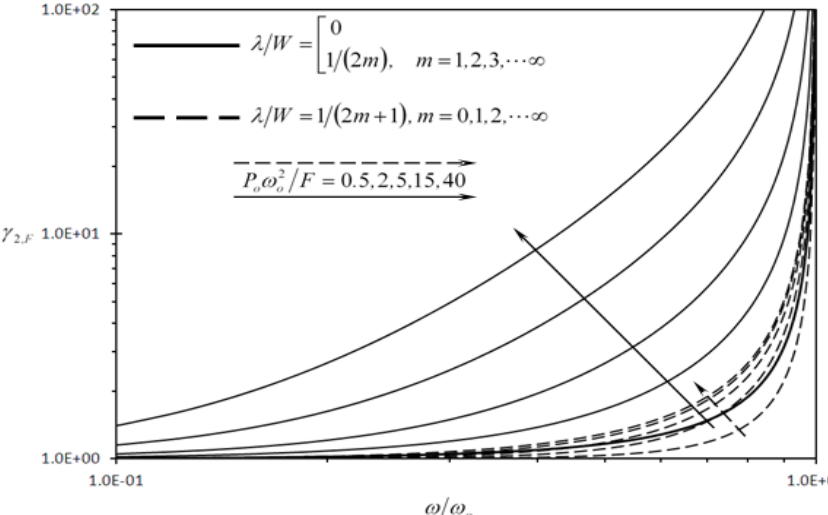
Figure 11. Effects of the dimensionless frequency of dynamic disturbance ( ω / ω power law index ( n ) and the second dimensionless dynamic disturbance force amplitude ω 2 ( L / d )/[ ∆ σ { P W (1 − v )]} on the second detection enhancement indicator of the o o o rectangular microcantilever with long-slit due to prescribed surface stress loading ( γ